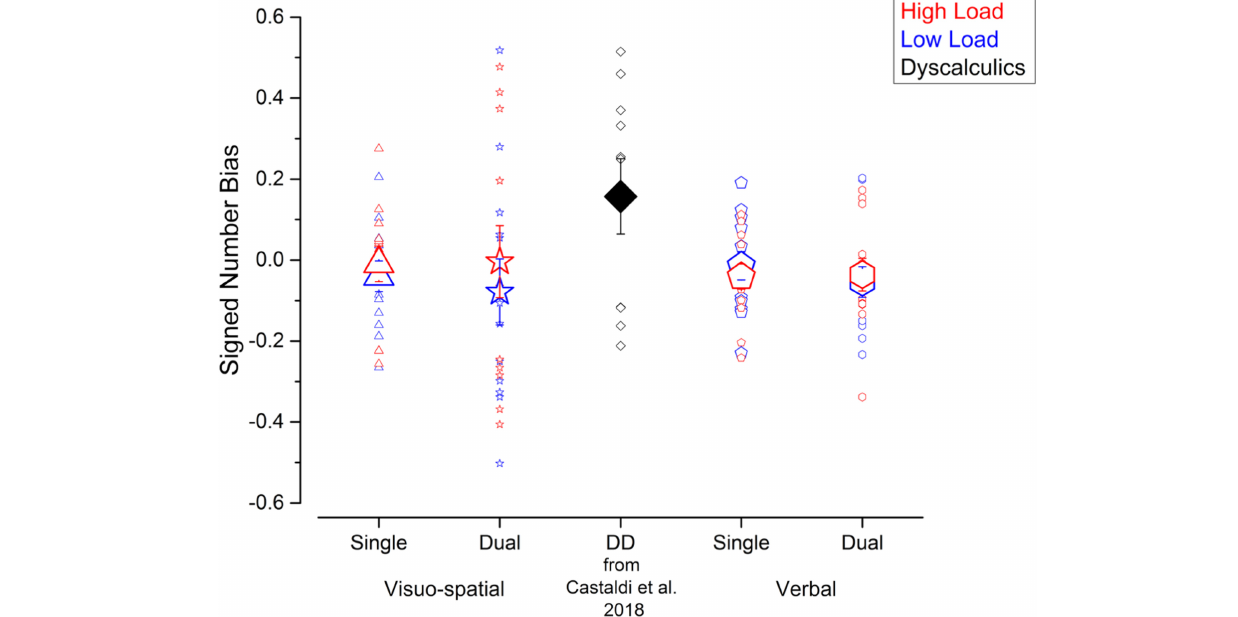
Frontiers in Human Neuroscience |